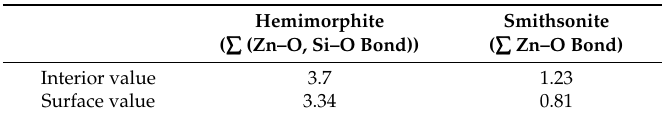
Table 4. Mulliken bond population of internal and surface chemical bonds of hemimorphite and